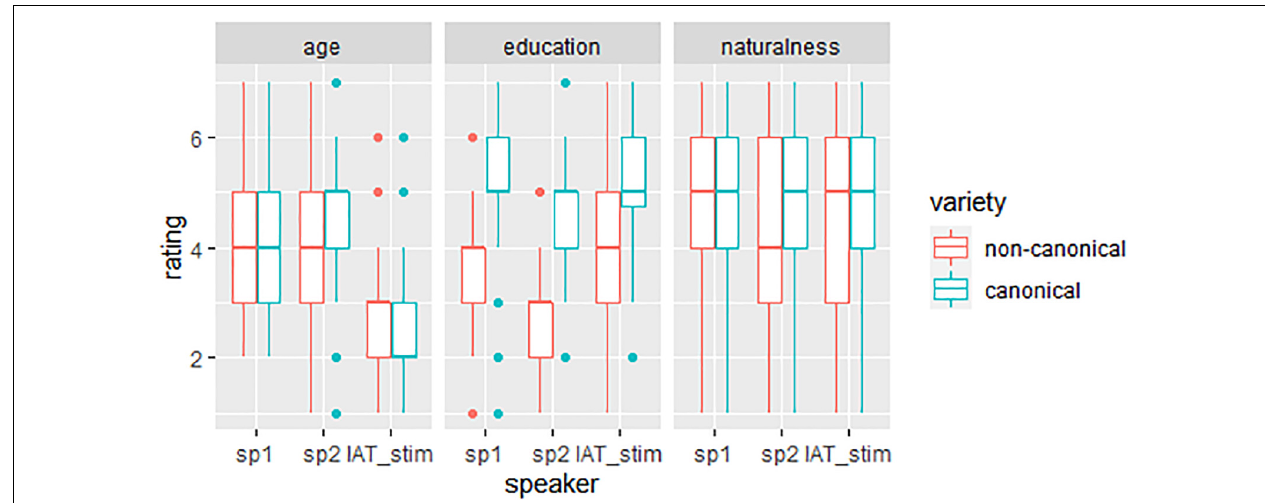
FIGURE 5 | Distribution of ratings regarding perceived age, education and naturalness separated by speaker (sp1, sp2, and IAT_stim) and variety (blue = / ç /, red = / ɕ